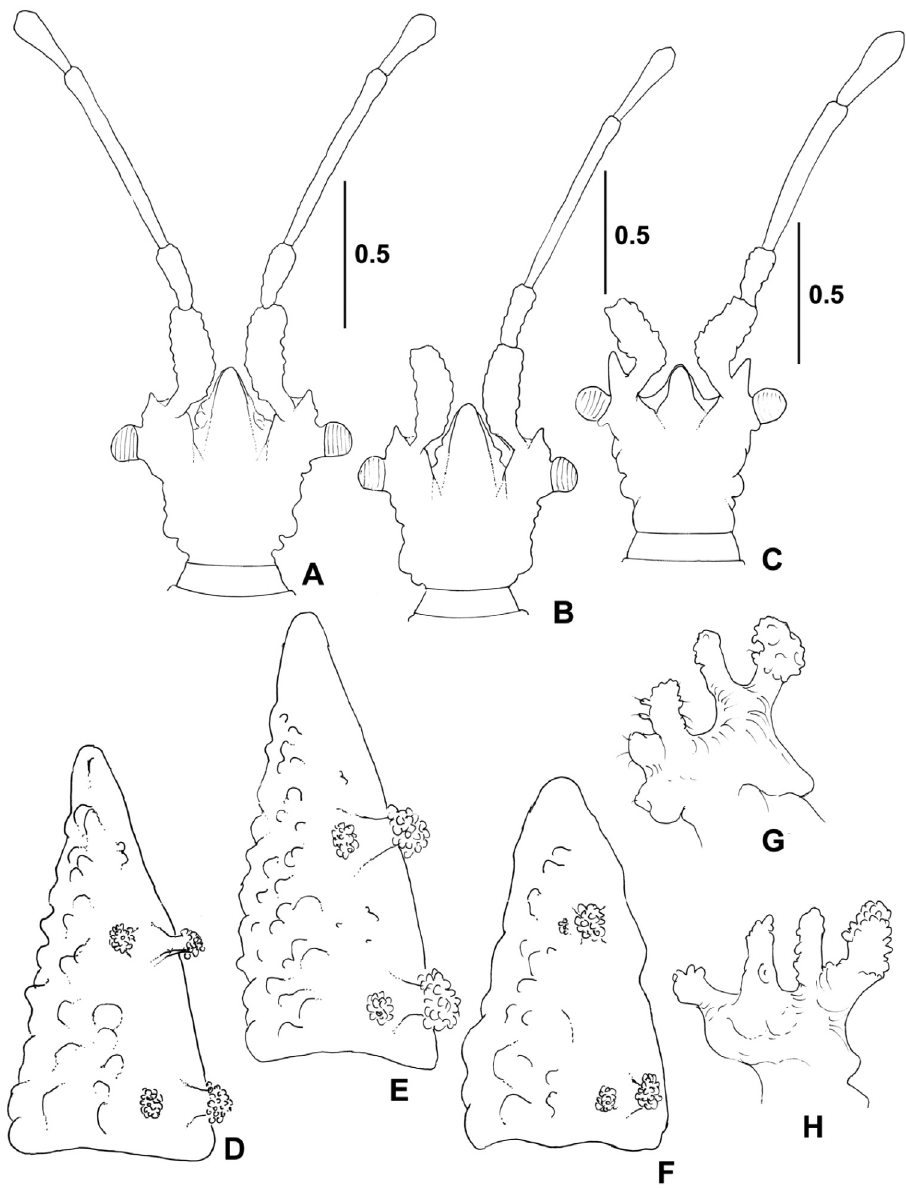
Figure 4. Cervinotaptera species. A–C outline of head D–F fused dorsal external laterotergites II+III G–H lateral finger-like processes of pronotum. A, D C. tomhenryi sp. n., male holotype B, E, G C. tom- henryi sp. n., female paratype C, F, H C. guilberti Heiss & Marchal, 2012, female holotype. Scale bars in mm, D–H schemes, not